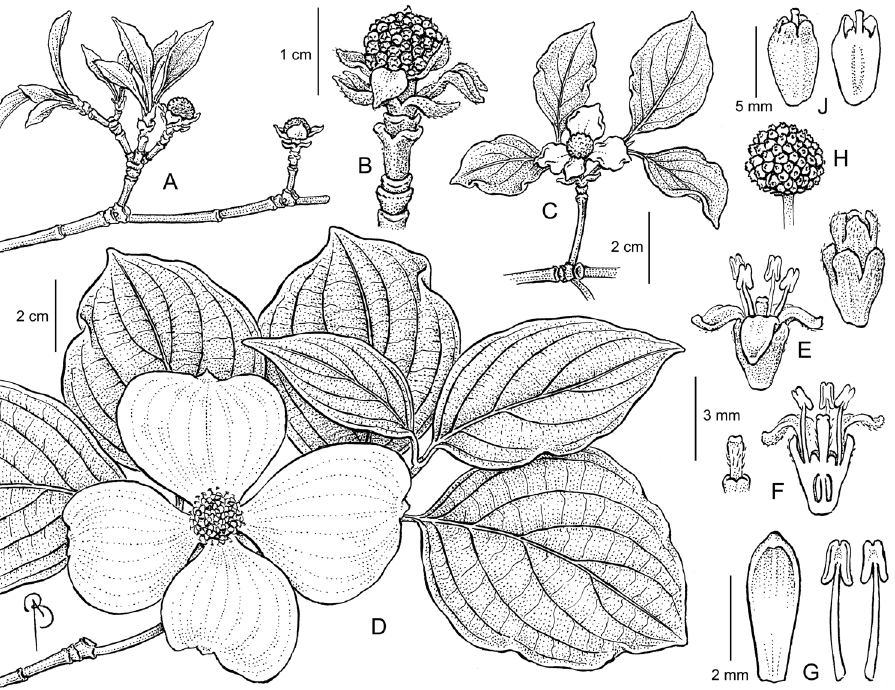
Figure 1. Illustration of Cornus × elwinortonii ‘KN4-43’, PP 16293, Starlight® . A Branch, showing ex- panding leaf and floral bract tissues in the spring B Close up of inflorescent bud prior to complete bract and leaf expansion C Node, showing fully expanded leaves and partially expanded floral bracts. D Branch, showing inflorescence with flowers in full bloom; floral bracts fully expanded E Close up of flower at dehiscence, note synsepalous calyx and apopetalous corolla F Dissected flower, showing single gynoecium G Close up of petal and stamens, note dehiscence occurs longitudinally H Single inflorescence, showing many tightly compressed parthenocarpic drupes J Single drupe, showing compressed form and protrud- ing style. Drawings by Bobbi Angell from the